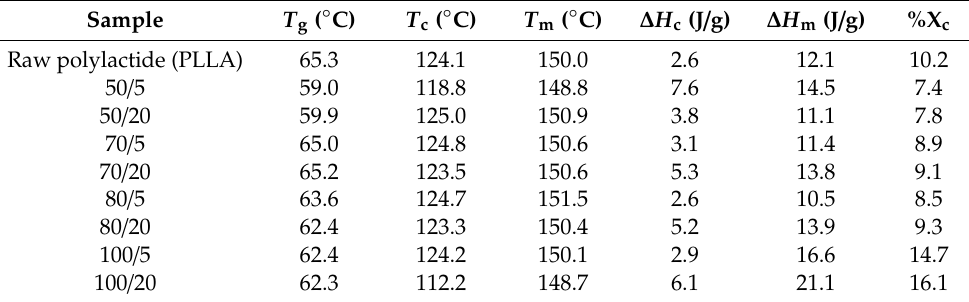
Table 3. DSC data of raw and annealed PLLA sheet.